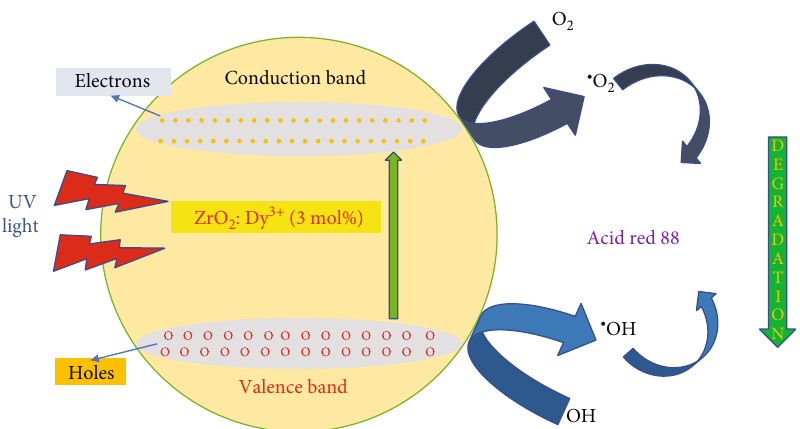
Figure 10: Proposed mechanism for the photocatalytic decolorization of AR88 dye over the ZrO